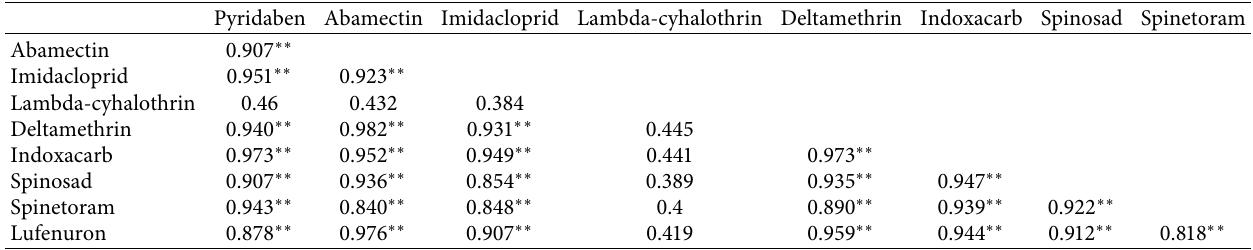
Table 6: Pairwise correlation analysis of the LC 50 values for nine insecticides in the 13 field populations of Spodoptera frugiperda. Pyridaben Abamectin Imidacloprid Lambda-cyhalothrin Deltamethrin Indoxacarb Spinosad Spinetoram